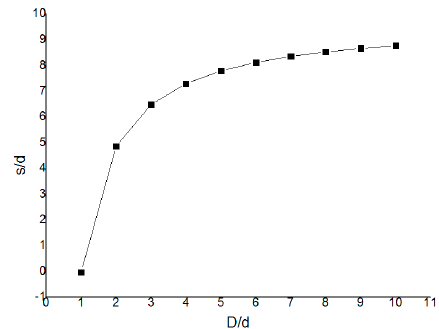
Figure 7. The relationship between s / d and β .